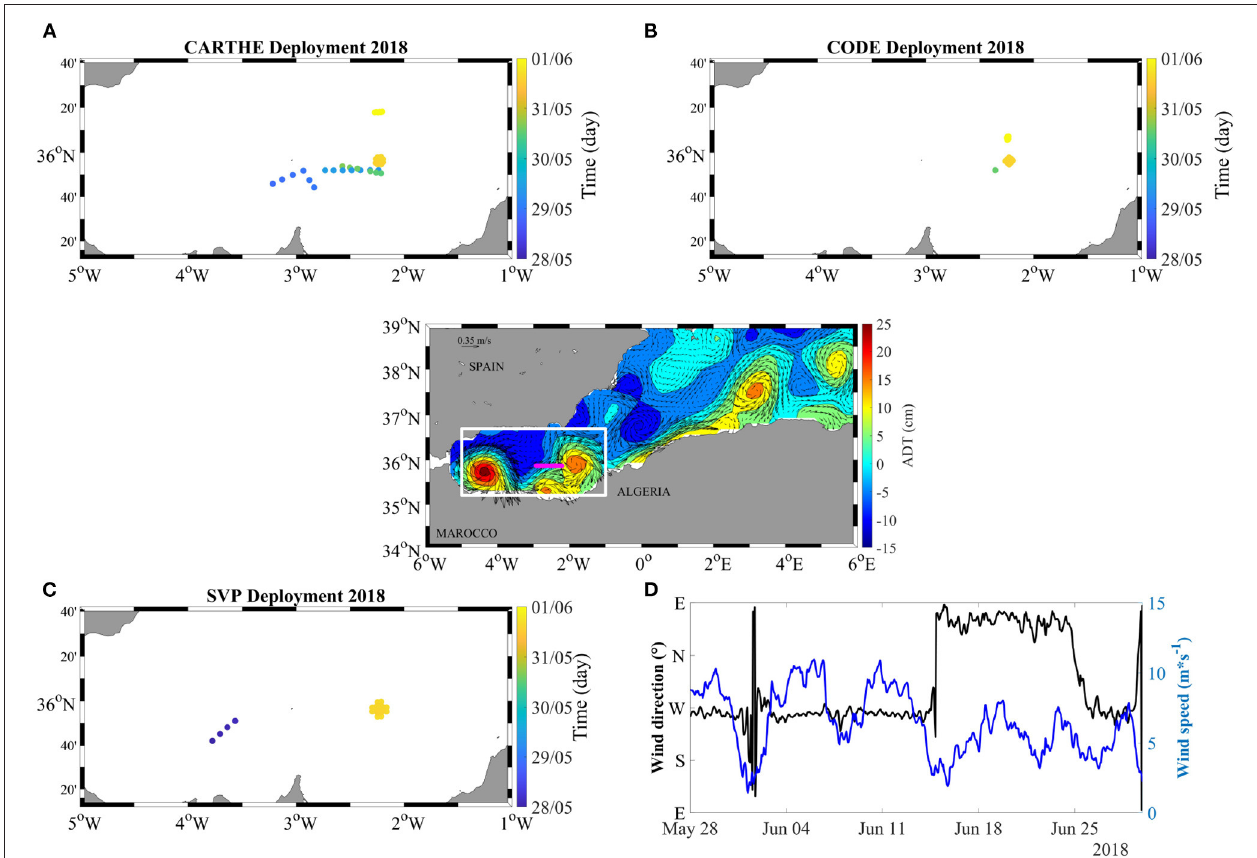
FIGURE 1 | Central panel: mean ADT (units in cm) and surface geostrophic current (black arrows) in the Alboran Sea from May 28 to June 29, 2018. The white box indicates the area of drifter deployments, the magenta line represents the position of the UCTD transect shown in Figure 3 . The inserts (A–C) show the color coded deployment sequence of CARTHE, CODE, and SVP. Panel (D) shows the wind speed (blue) and direction (black) time series, averaged over the white box coverage in the central panel.